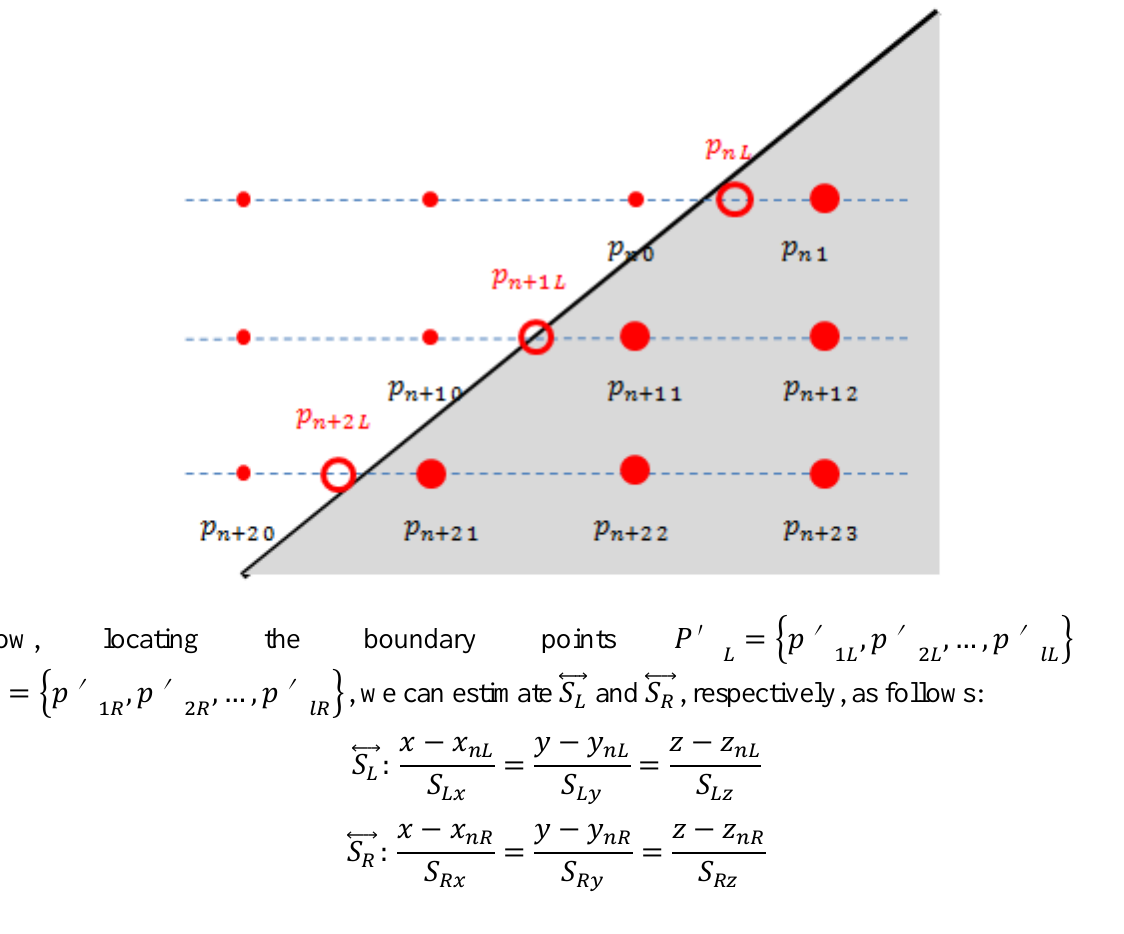
Figure 9. Virtual points (empty circles) near the side